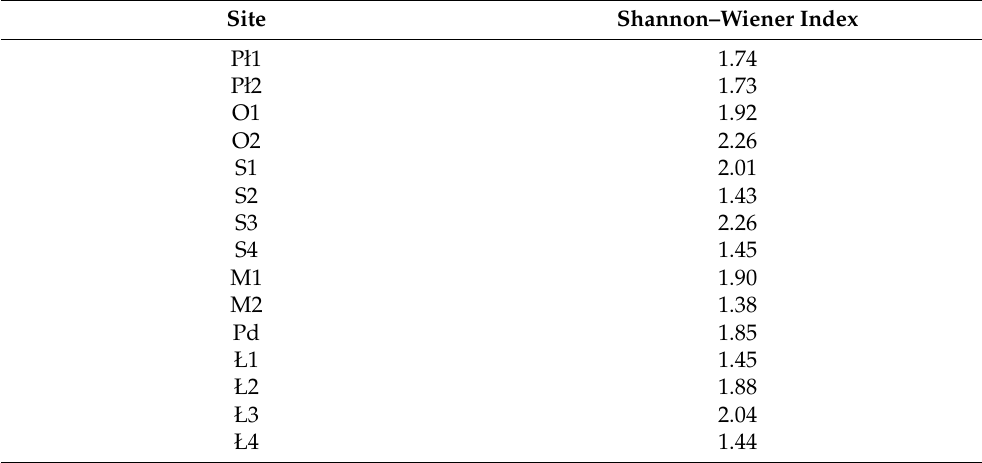
Table 5. Index of Shannon–Wiener